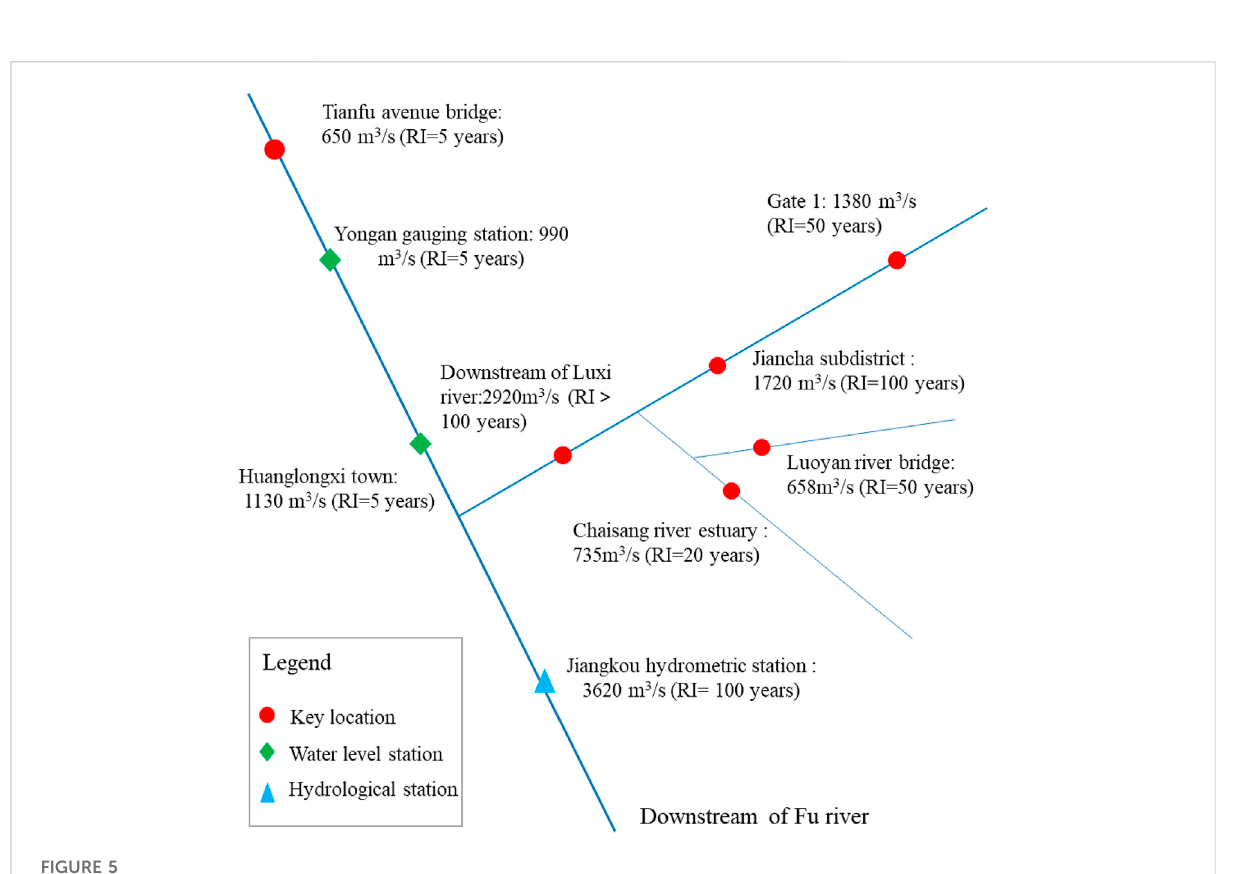
FIGURE 5 Distribution of peak discharge